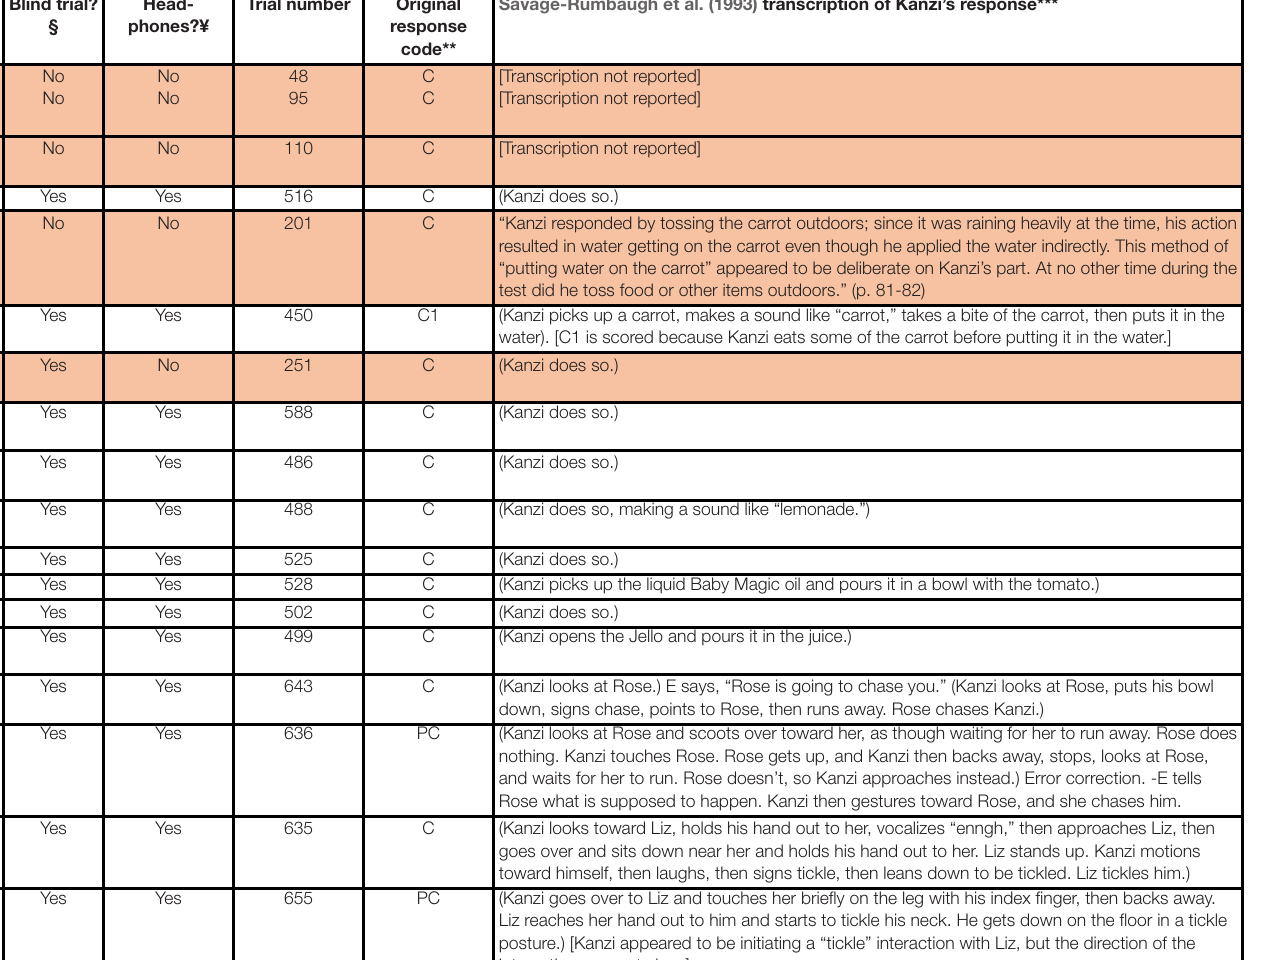
TABLE 1 | Kanzi’s performance on reversible sentences (from Savage-Rumbaugh et al., 1993). Performance on Command pair*